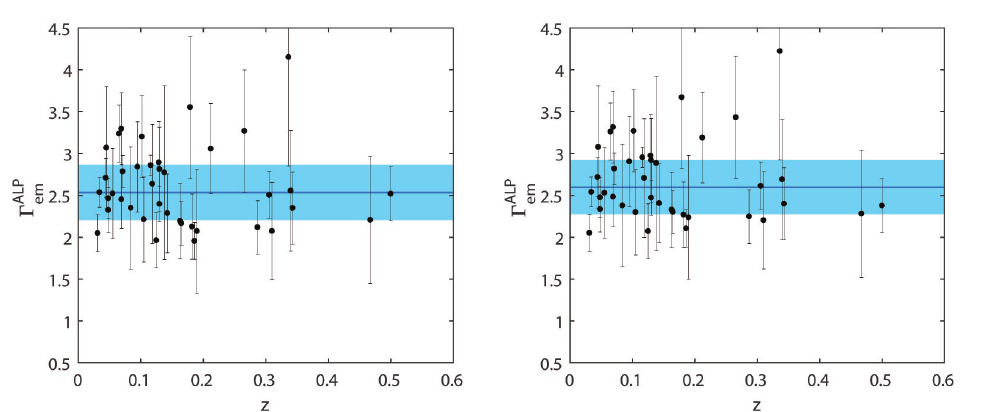
Figure 12. The values of Γ ALP em with the corresponding error bars are plotted versus z for all considered blazars within S in the ALP scenario. The light blue strip encompasses 95% of the sources. Left panel : Case L dom = 4Mpc. Superimposed is the horizontal straight best-fit regression line Γ ALP em = 2.54 with = 1.29 and the width of the light blue strip is ∆Γ ALP = 0.66 which equals 26% of the value χ 2 em red,ALP Γ ALP = 2.54. Right panel : Case L = 10Mpc. Superimposed is the horizontal straight best-fit dom em = 1.25 and the width of the light blue strip is ∆Γ ALP = 0.65 regression line Γ ALP em = 2.60 with χ 2 em red,ALP which equals 25% of the value Γ ALP em = 2.60. (Credit